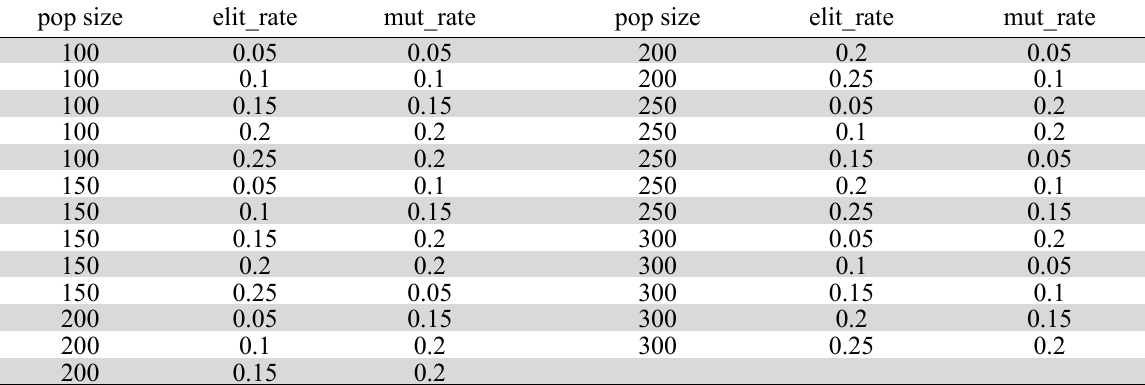
Adjusted design L25 (53)